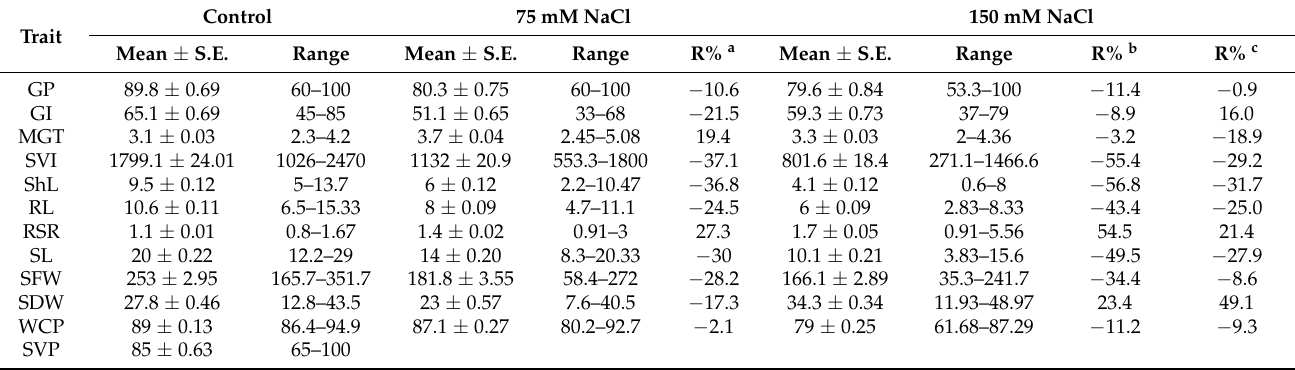
Table 2. Summary statistics and reduction percentage (R%) due to salinity effects on the studied traits as compared to control. Trait